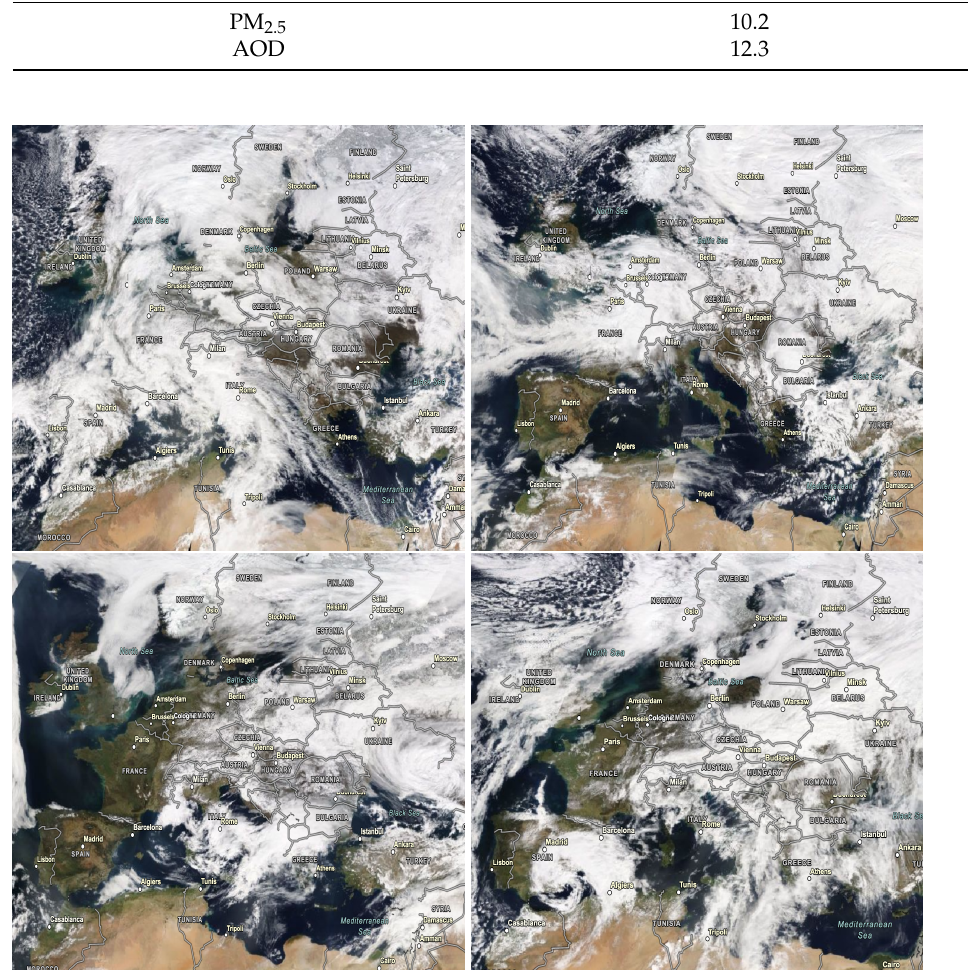
Figure 8. MODIS Terra cloud corrected reflectance on 1 March ( top left panel ), 10 March ( top right panel ), 20 March ( lower left panel ) and 30 March ( lower right panel )